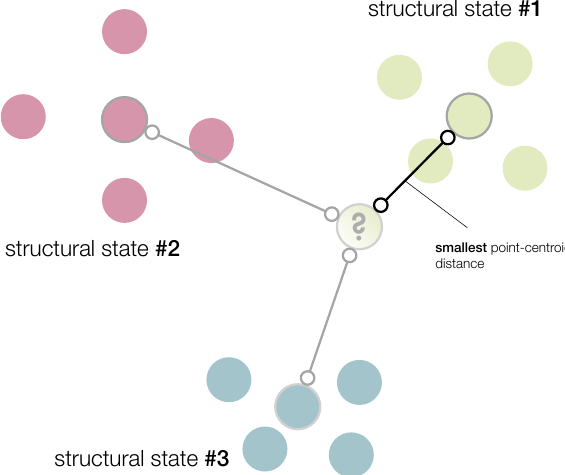
Figure 1. The current structure to diagnose is associated to the structural state with the smallest point-centroid distance.